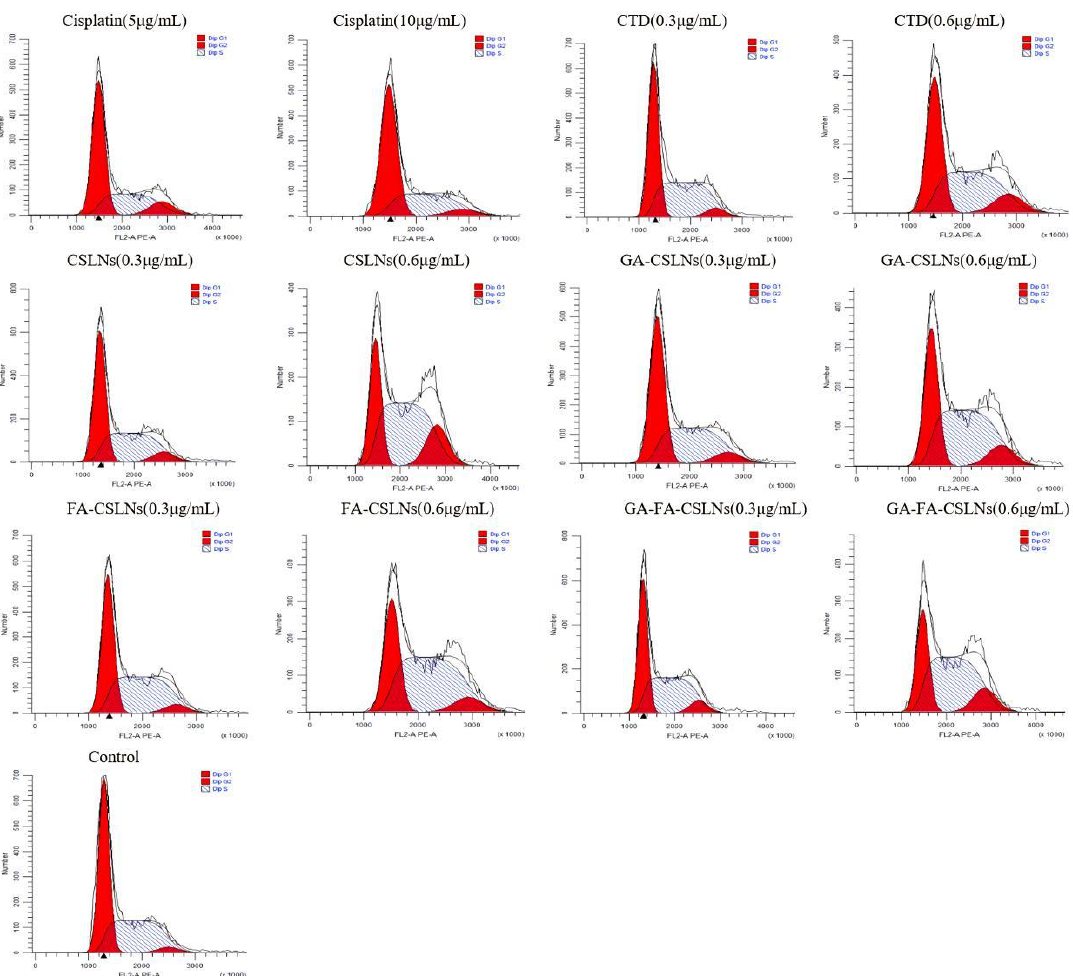
Figure 11. Cell cycle diagram of SLNs modified with different ligands on HepG2.